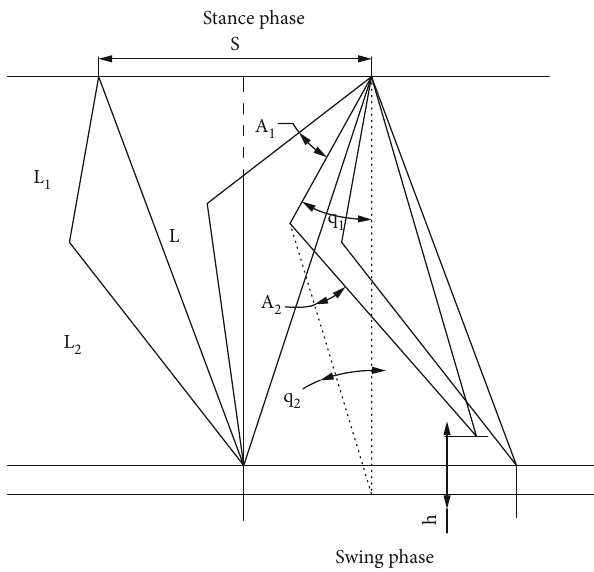
Figure 1: Motion of robots.